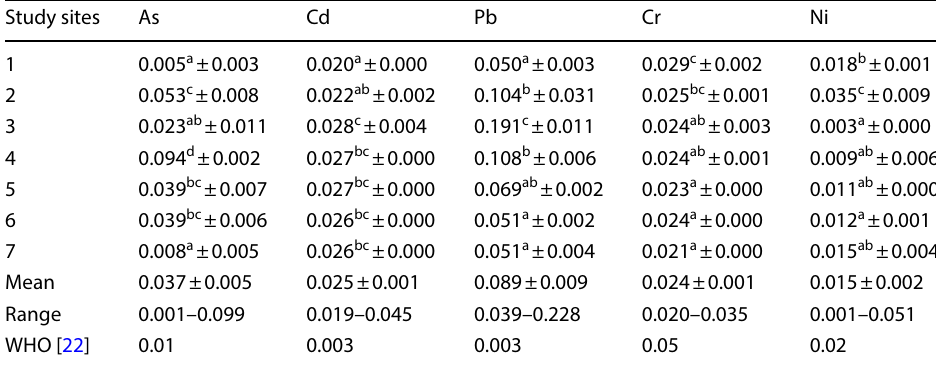
Table 6 Heavy metal concentration (ppm) in Indus river water of the cold desert high-altitude trans-Himalayan